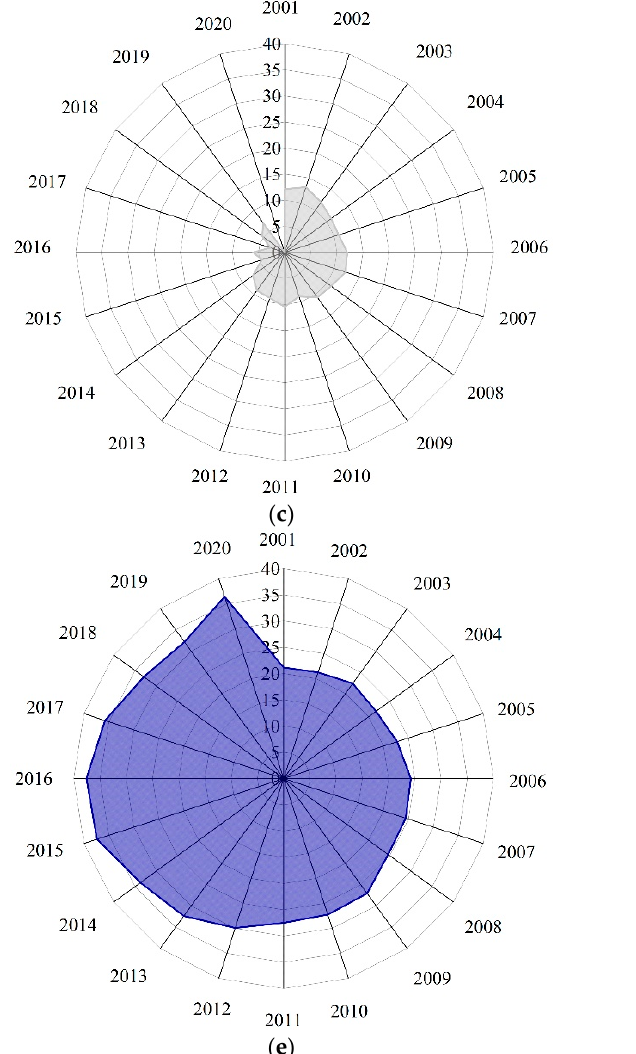
Figure 3. Heatmap of the obstacle degree of each index from 2011 to 2020.